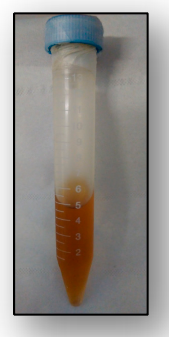
Figure 1. Final sample of G90E8B2 after filtering.